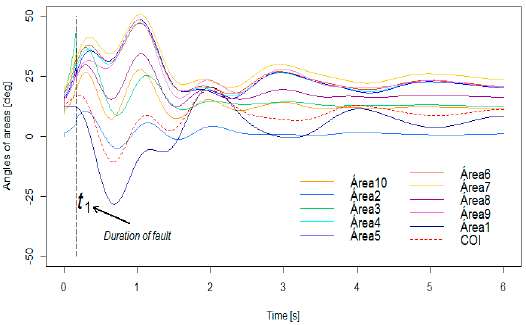
Figure 4. Voltage angles measured in the generation buses after fault clearance at 0.17 s.